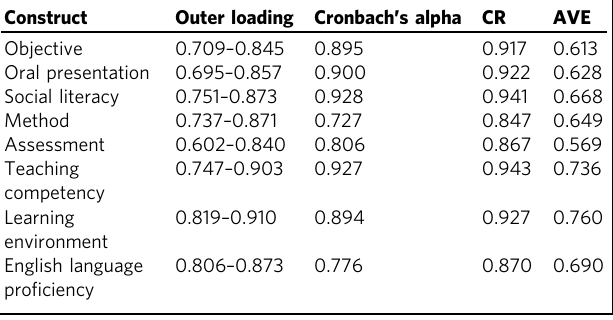
Table 7 Assessment of the measurement